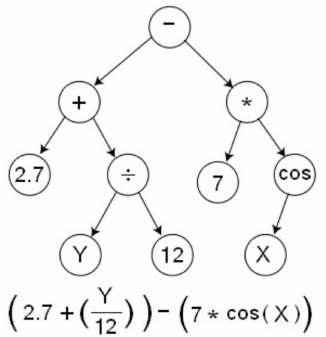
Figure 10. Tree structure of genetic